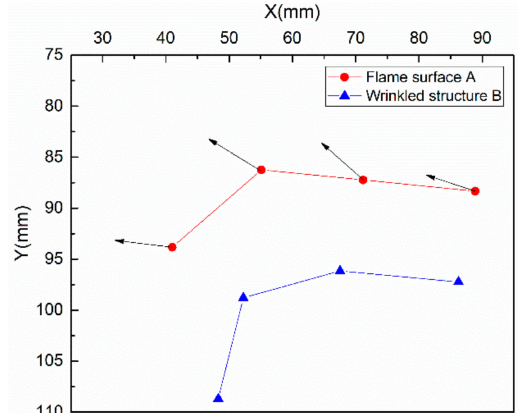
Figure 5. The displacement vector diagram of wrinkled structure and flame surface. The arrow represents the normal line of the flame surface. The flame propagation direction is from right to left, and the distance coordinates correspond to the field of view.